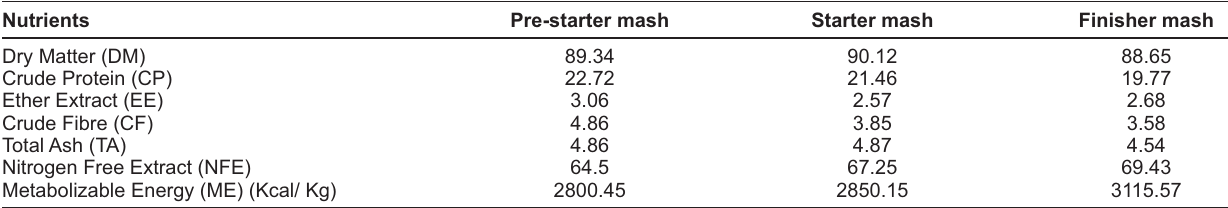
Table-1. Proximate composition of pre-starter, starter and finisher diet of broiler chicken. Nutrients